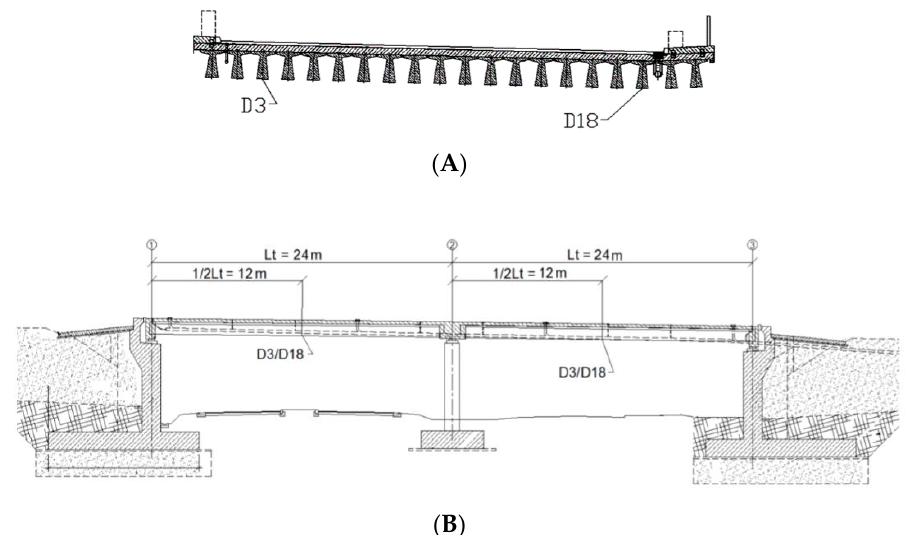
Figure 9. Arrangement of measuring sensors in cross-section ( A ) and longitudinal section ( B ) of the object.